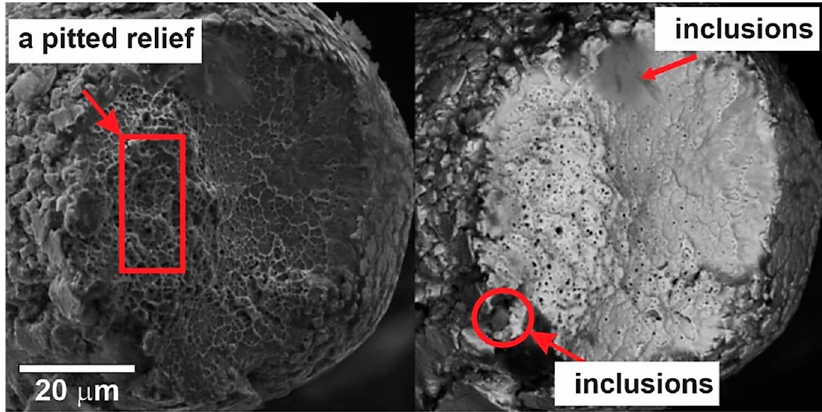
Figure 11. The fracture surfaces of a 90 µm thick NiTi wire.